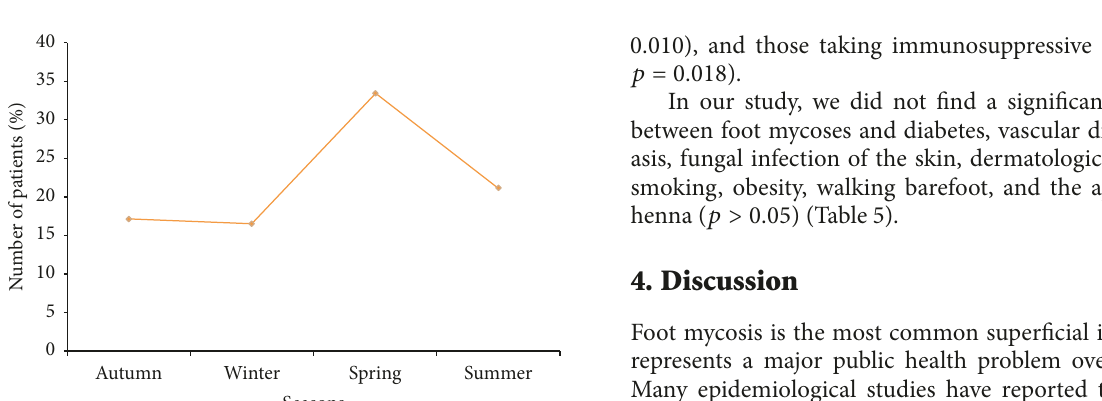
attending thermal station (8.3%; 𝑝 = 0.021 ), pedicure (14.1%; 𝑝 = 0.006 ), associated fingernails onychomycosis (7.5%; 𝑝